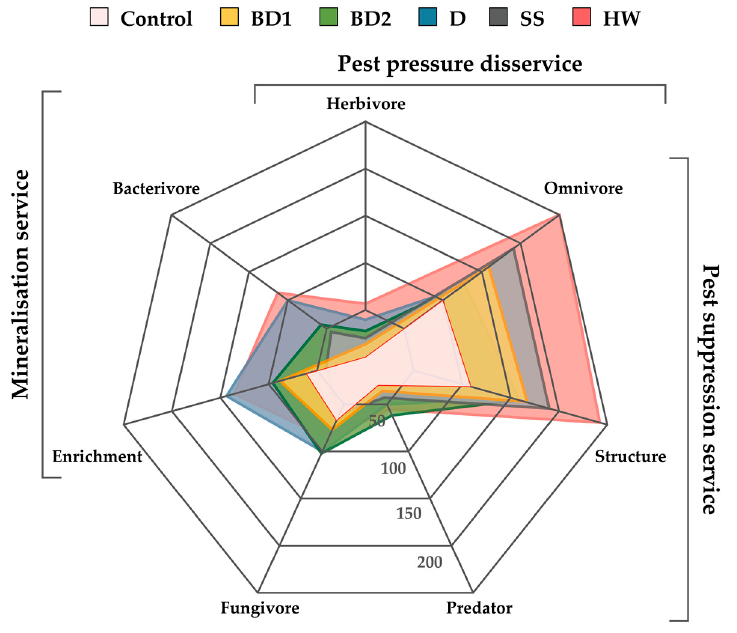
Figure 3. Radar chart of the metabolic footprint of each nematode trophic group in the different treatments and delivered ecosystem services. treatments and delivered ecosystem